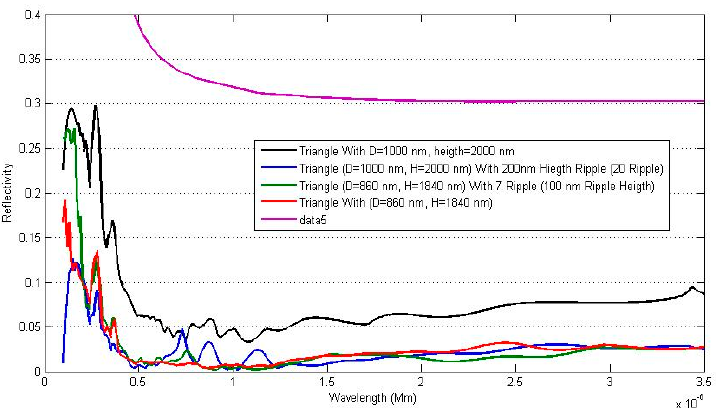
Figure 6. Spectral reflection of triangular surface rippling of triangular microstructures.